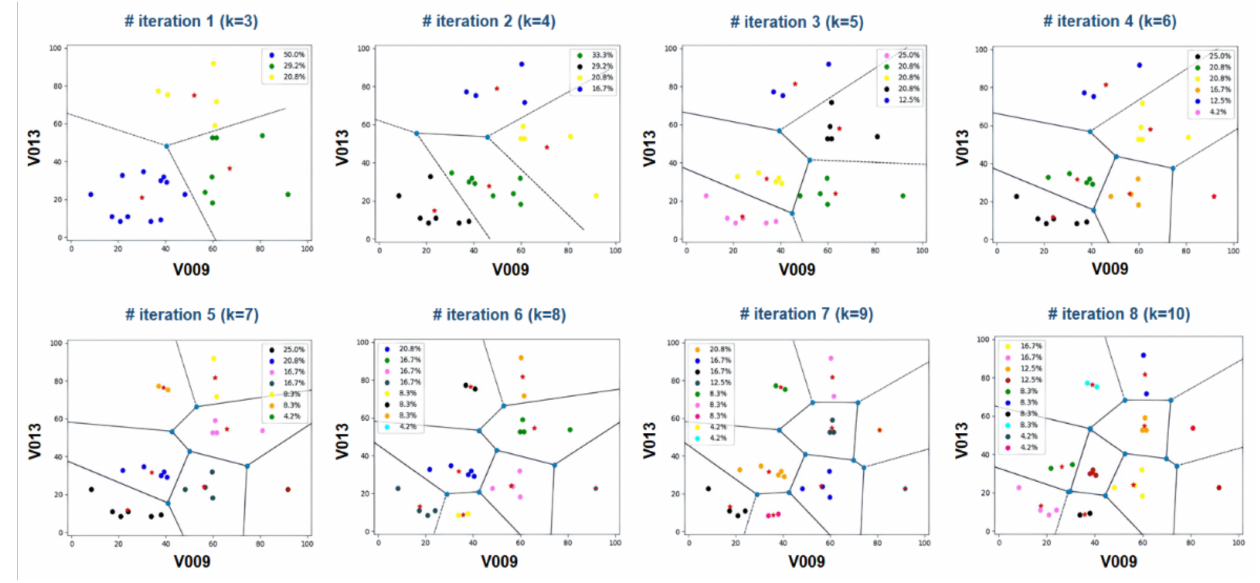
Figure 5. Clustering method to understand the intra-class similarity between two non-correlated sensors. This clustering method was iterated with different k values ( k = 3~10), standing for the number of clusters.